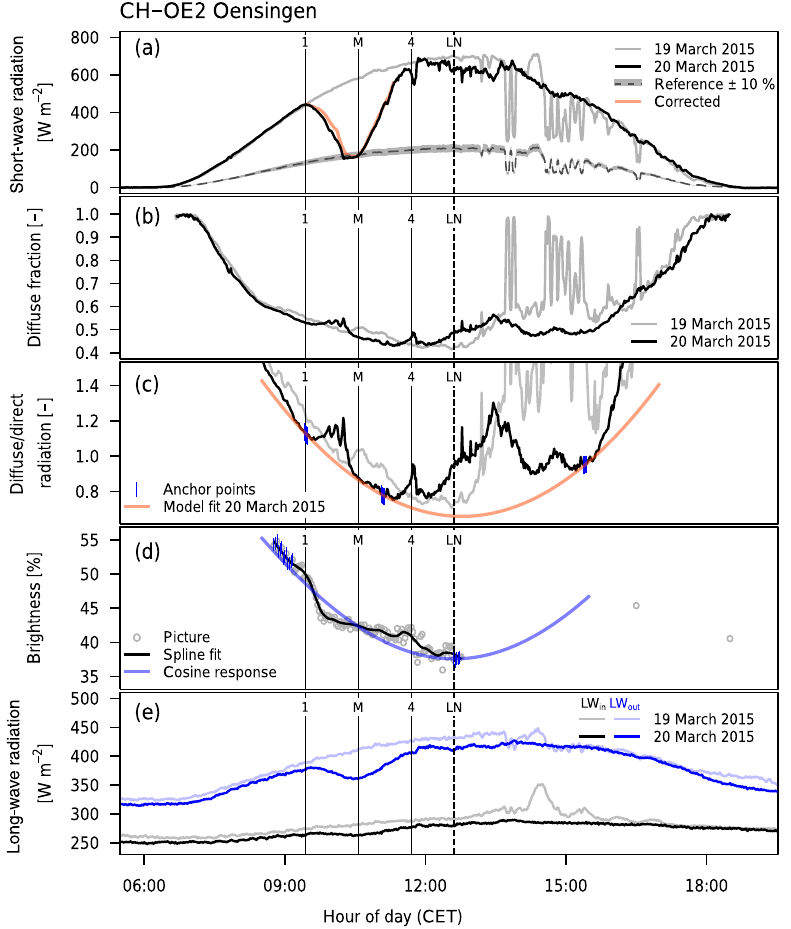
Figure 2. Radiation effects at the CH-OE2 Swiss FluxNet site. (a) Incoming short-wave radiation, (b) fraction of diffuse radiation, (c) ratio between diffuse and direct radiation, (d) evolution of brightness of the vegetation during the eclipse, and (e) long-wave radiation components. The four vertical lines indicate first contact (1), maximum occultation (M), fourth contact (4), and local noon (LN). Bold lines show the conditions during the day of the eclipse (black or darker color) in comparison with the preceding day (brighter color). The dashed reference curve in (a) is the measurement from 19 March 2015 multiplied by 0.6996, the theoretical maximum occultation at the site ( ± 10% shown with a gray band). The fraction of diffuse radiation in (b) was measured with a quantum sensor measuring diffuse photosynthetic photon flux density (PPFD, 400–700nm wavelength) in relation to total PPFD. The red model curve in (c) shows an empirical parabolic fit to the three periods with blue data points to obtain a reference for the correction of (a) for cloud passage during the eclipse (red line in a ). The assumption made here is that the ratio of diffuse to direct PPFD is valid also for the entire wavelength spectrum of short-wave radiation shown in (a) . During the penumbral shading phase, the phenological camera recorded images every 2min, from which relative surface brightness was computed in the footprint area of the radiation measurements (gray symbols in d ). The local polynomial regression fit (black line in d ) shows a marked decrease in brightness after first contact in comparison to the theoretical cosine response (blue line in d ), anchored at the pictures marked with vertical blue bars), followed by an almost constant brightness during the occultation phase. LW in and LW out in (e) are incoming and outgoing long-wave radiation,